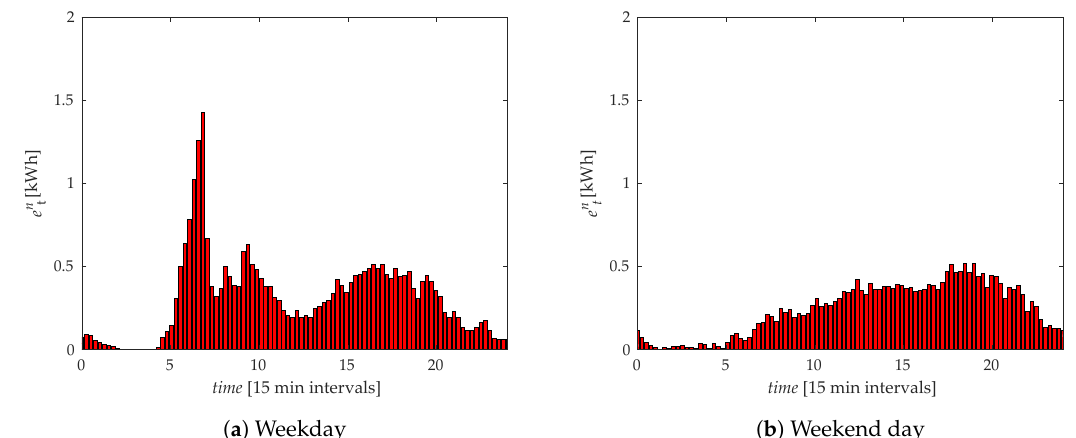
Figure 6. Average energy not charged due to plugged-in fully charged PEVs in each interval for a N =